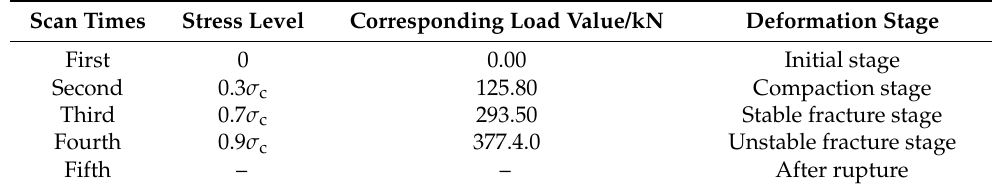
Table 1. Scanning times and states of